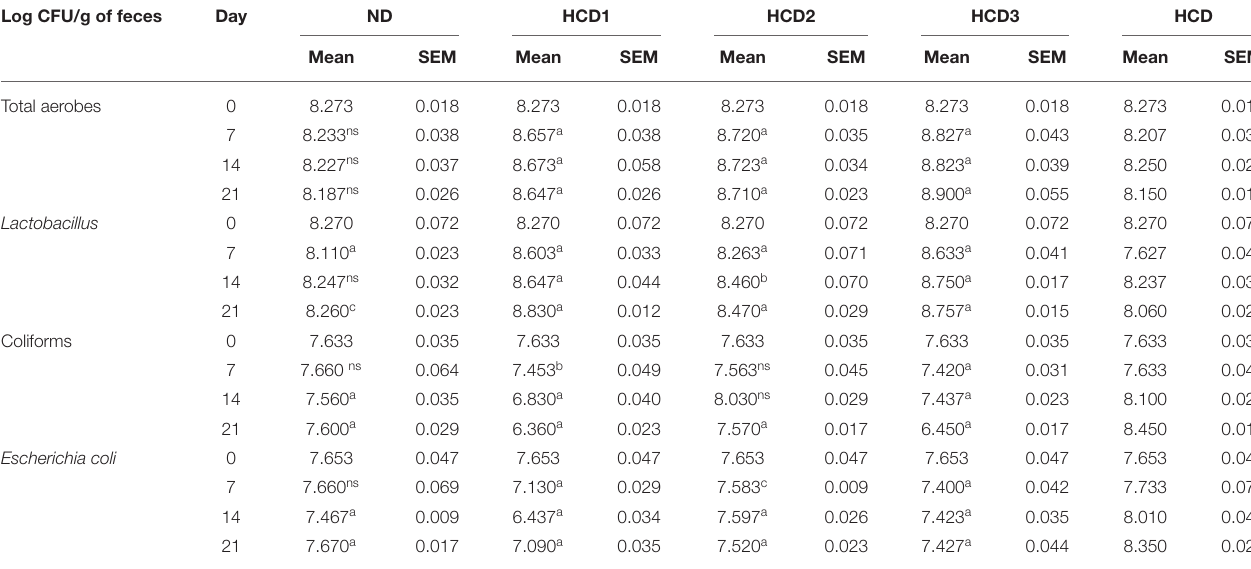
TABLE 8 | Effect of feeding probiotics on fecal bacterial population ( n = 3). Log CFU/g of feces